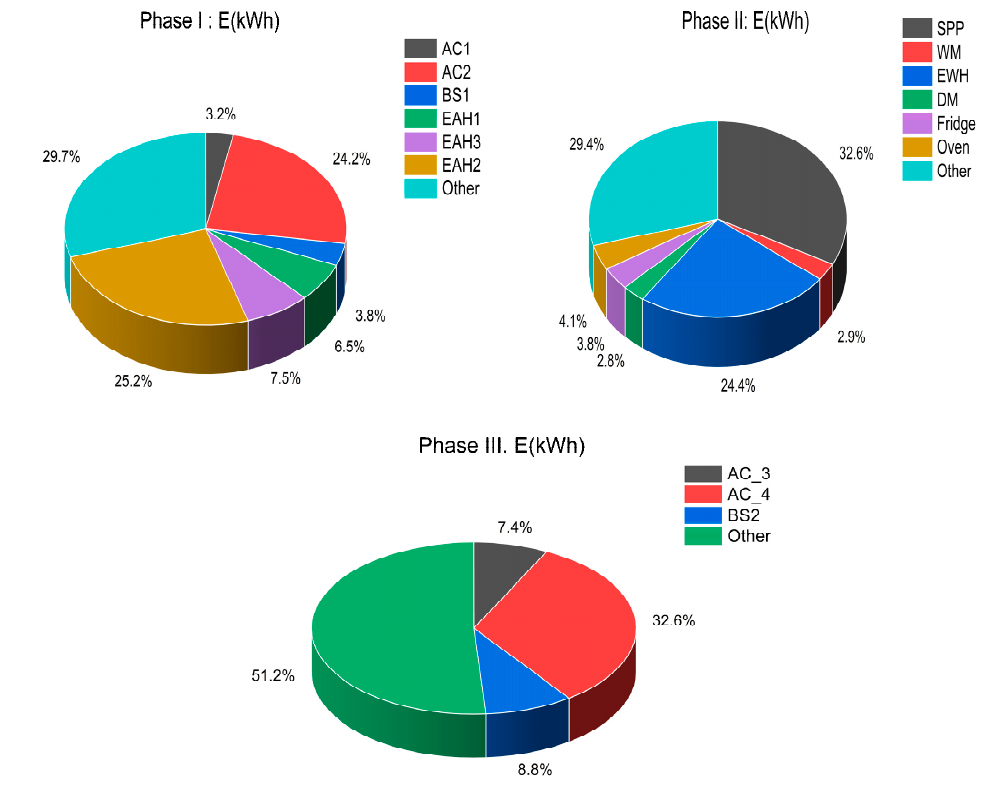
Figure 11. Distribution of electricity consumption.